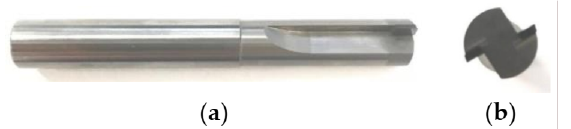
Figure 2. The CVD diamond milling cutter: ( a ) front view; ( b ) side view.